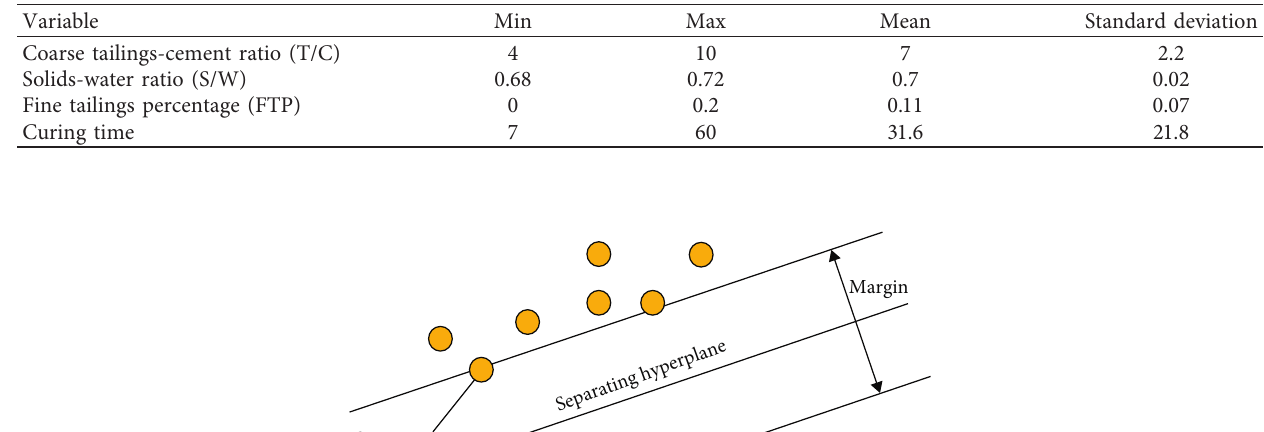
Table 1: Statistics of influencing variables.